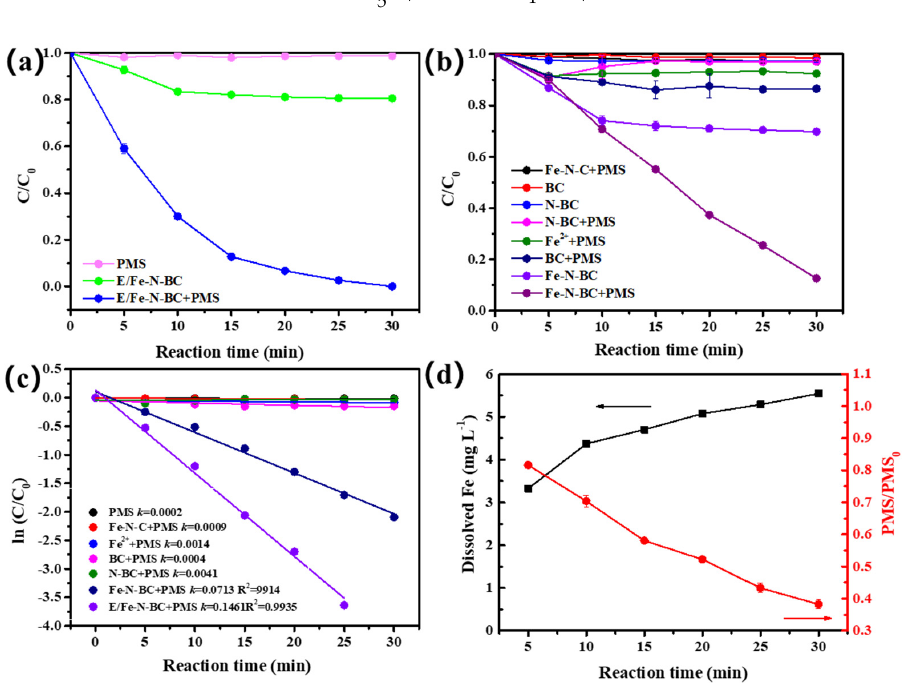
Figure 3. Removal efficiency of QNC in various systems ( a , b ). Reaction kinetics of QNC in different reaction systems ( c ). Residual rate of PMS and dissolved Fe in E/Fe–N–BC/PMS system ( d ). Reaction condition: [QNC] = 10 mg·L − 1 , pH= 4.2, T = 25 ± 1 °C, [catalyst] = 0.3 g·L − 1 , and [PMS] = 0.8 mM.